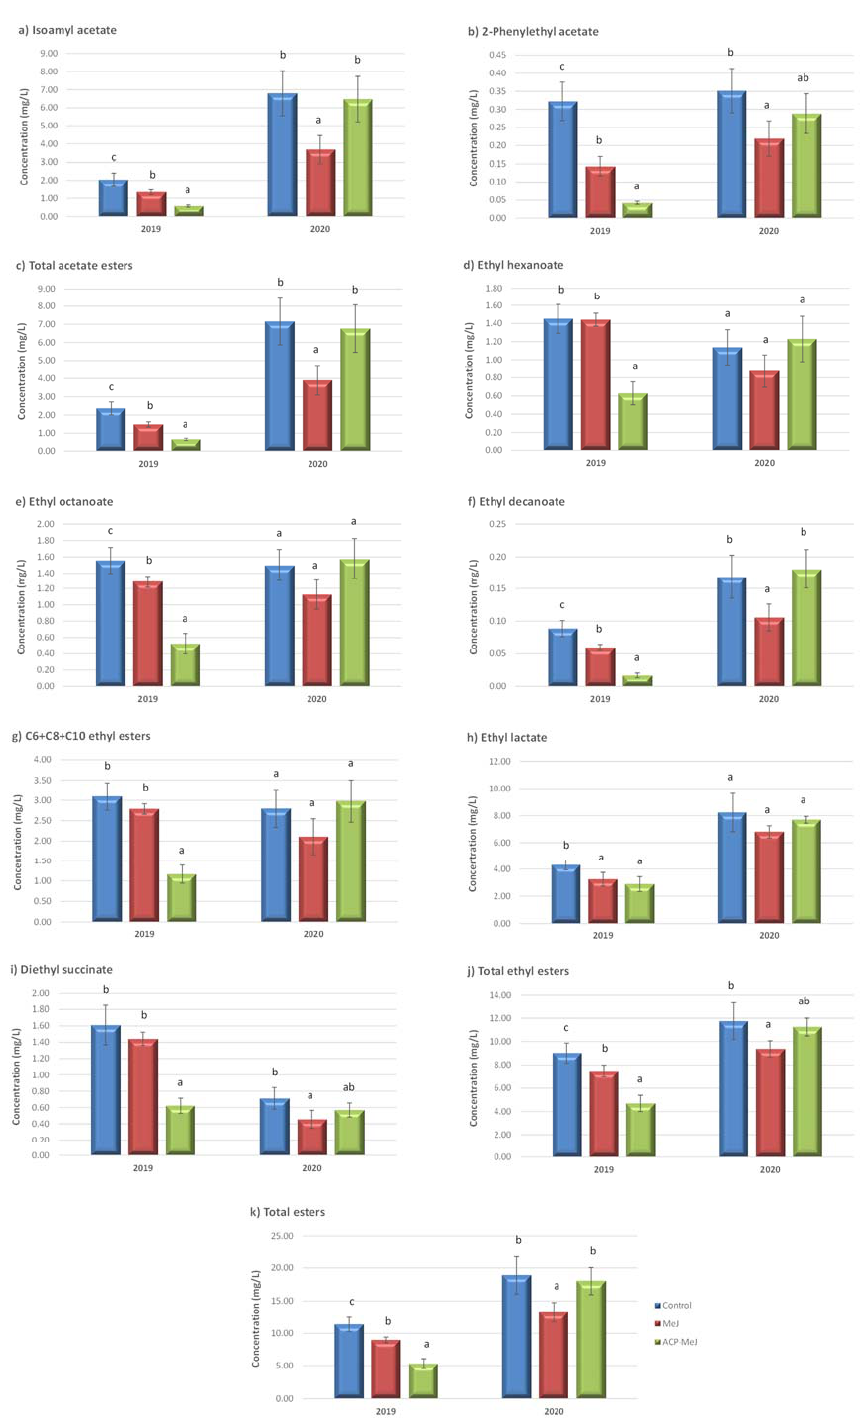
Figure 1. Esters concentration (mg/L) in control wines and from methyl jasmonate (MeJ) and apatite doped with methyl jasmonate (ACP-MeJ) treatments, in the two seasons (2019 and 2020). All parameters are listed with their standard deviation ( n = 3). For each season and compound, different letters indicate significant differences between the samples ( p ≤